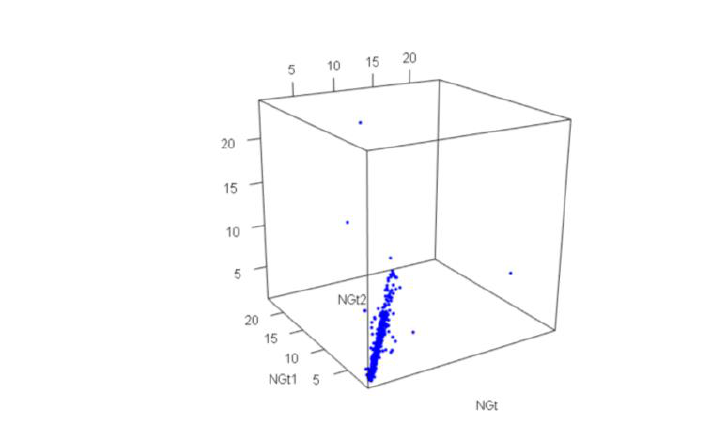
Figure 3: Multiple-equilibria in Natural gas prices; Source: Author